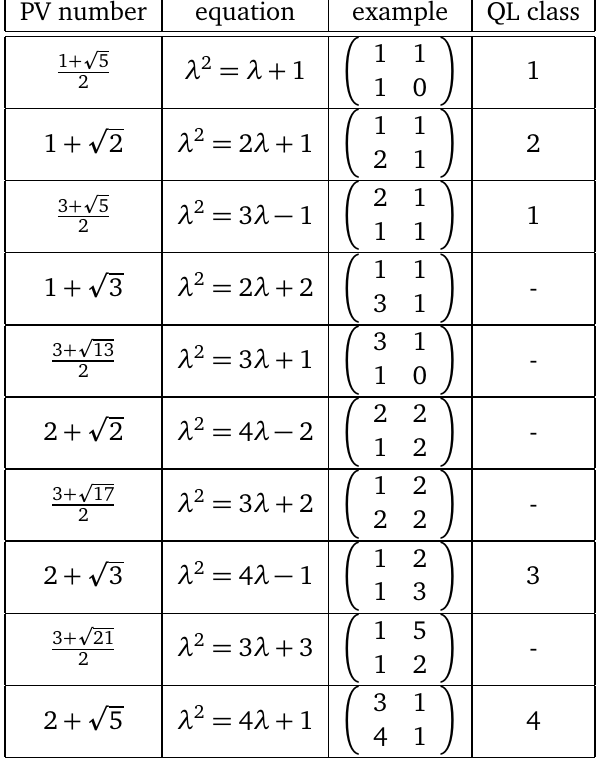
Table 1: The first few quadratic-irrational Pisot-Vijayaraghavan (PV) numbers. Each is the root of a monic quadratic equation uniquely specified by the number, listed in the second column. This equation always corresponds to the characteristic equation of a 2 × 2 matrix with non-negative integer entries; an example is given in each case in column three. The trace is given by the coefficient of the linear term in the equation, and the determinant the negative of the constant term. If the determinant has unit magnitude the number relates to a quasilattice inflation rule. The Boyle-Steinhardt class of the quasilattice is listed where applicable (see Table 2). PV number equation example QL class (cid:18) (cid:112) 1 1 1 + 5 λ 2 = λ + 1 2 1 0